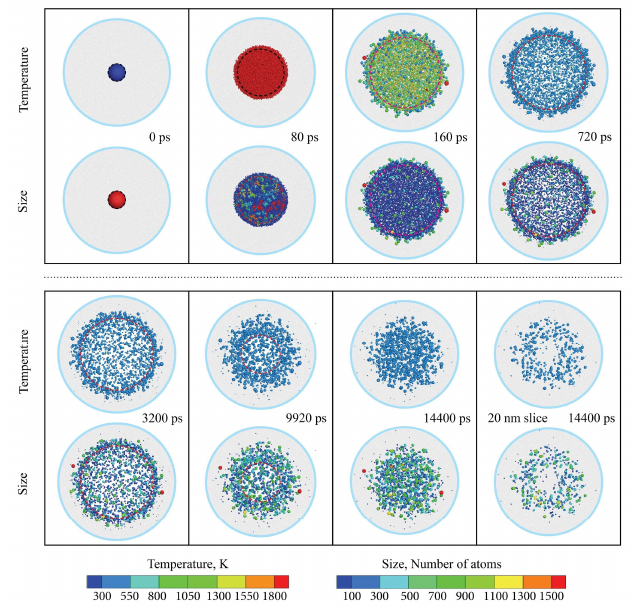
Figure 5. Snapshots of cluster-based TTM-MD simulation of laser fragmentation in liquid [25]. Reprinted with permission from Ref. [25]. Copyright 2021 American Chemical Society.